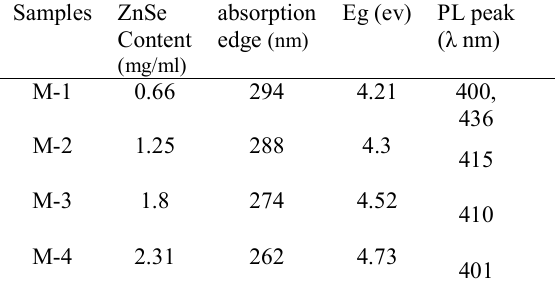
Table 3: Absorption spectra/ Photoluminescence analysis of